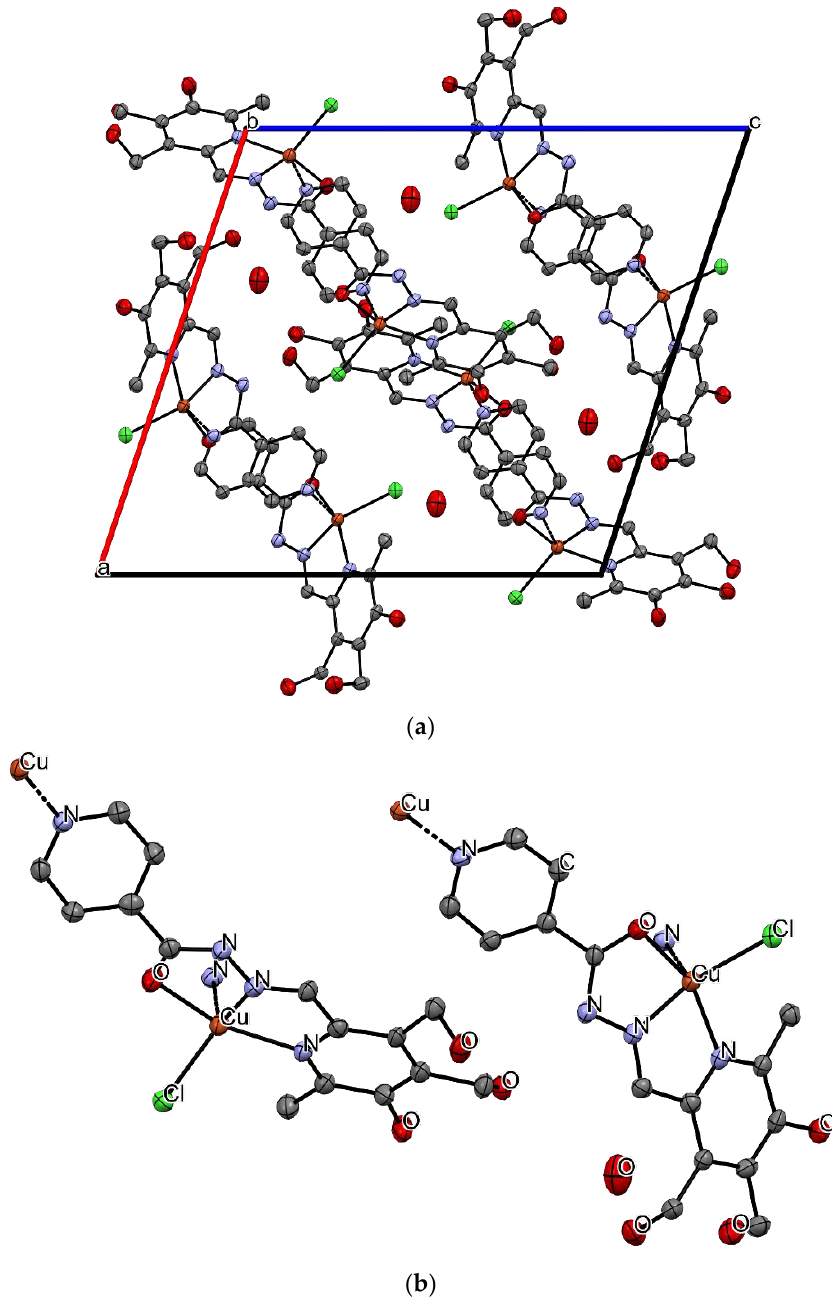
Figure 2. ( a ) View of a unit cell along the b axis of the corresponding crystal structure. ( b ) Complex unit of {[Cu𝐋Cl] ∙ 0.5H 2 O} ∞1 . Thermal ellipsoids describe a 50% probability level of atoms; hydrogen atoms are omitted for clarity. The dashed Cu–N bond is a polymeric one.